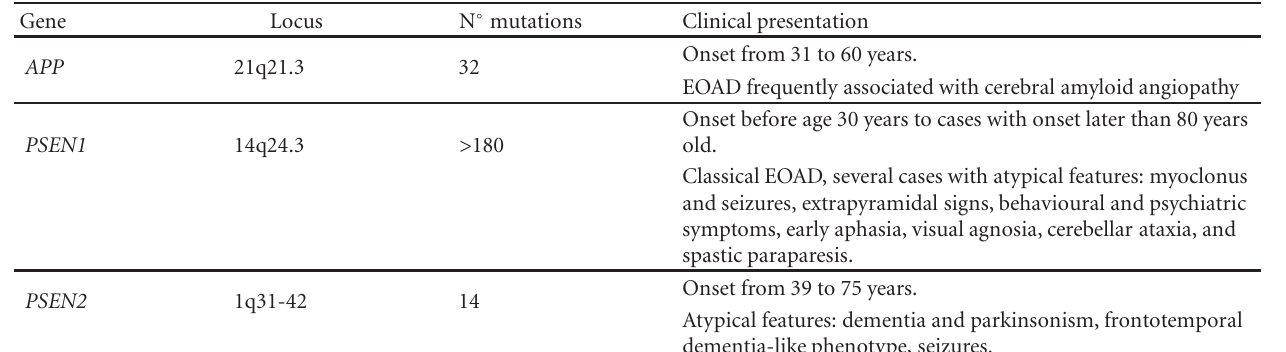
Table 1: Monogenic forms of Early-Onset Alzheimer’s Disease